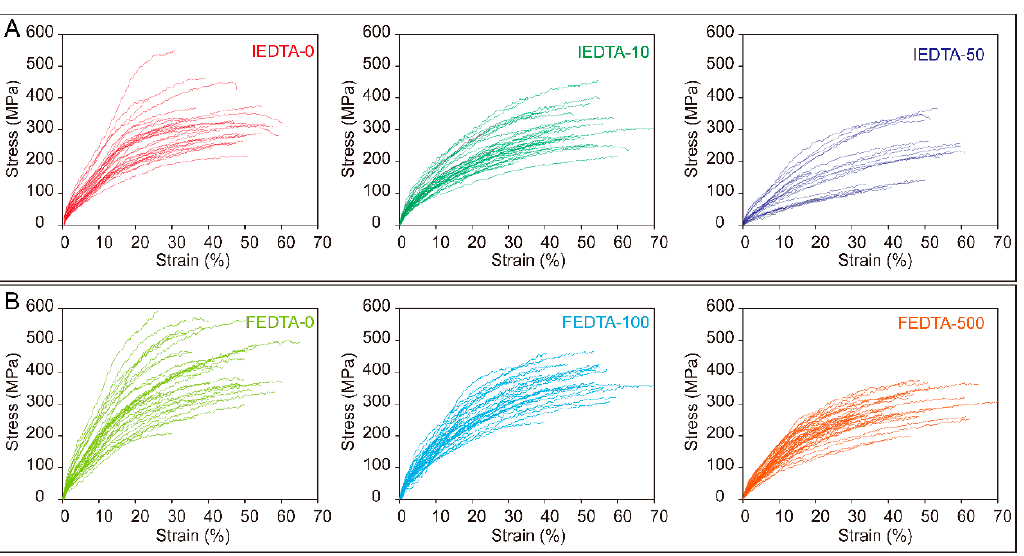
Figure 5. Stress-strain curves of the silk fiber after treatment. ( A ) The silk fiber reeled from silkworms injected of EDTA; ( B ) The silk fiber reeled from silkworms fed with EDTA.